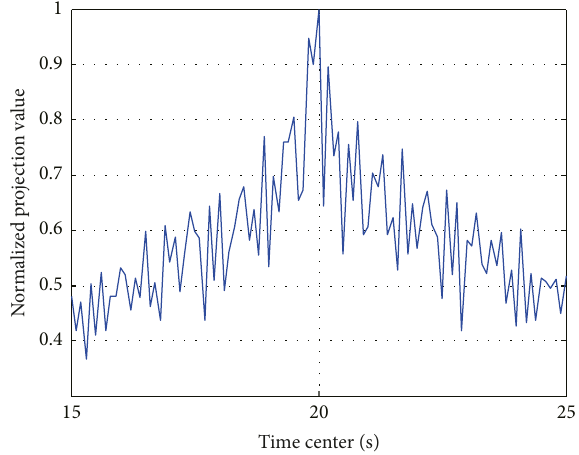
Figure 8: Curve of outlier data feature state response distribution detected with dynamic scheduling of information flows (the tradi- tional